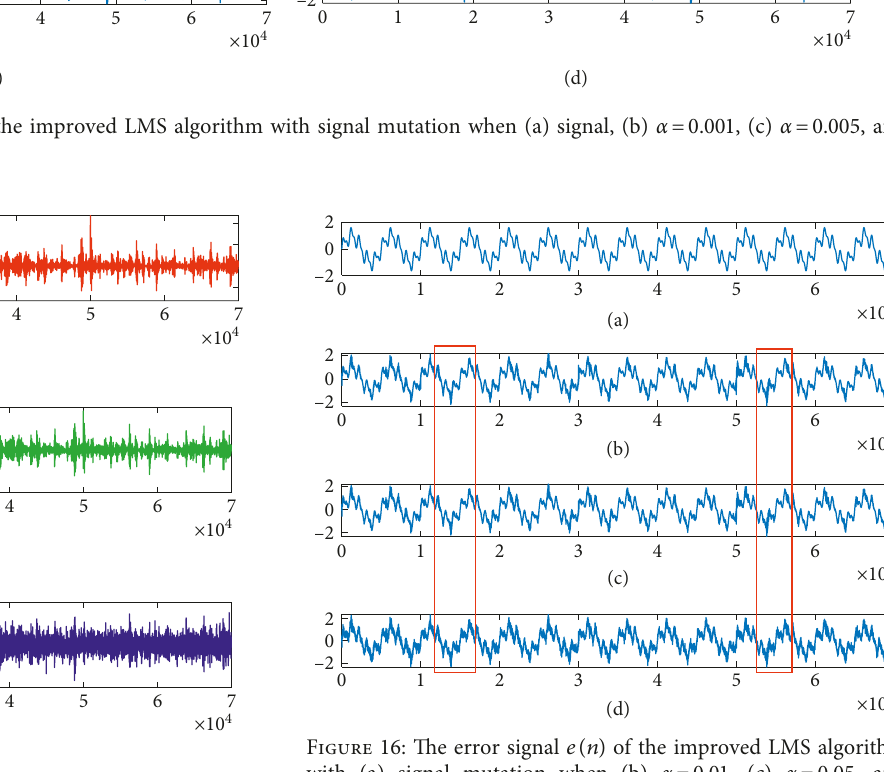
Figure 15: The residual noise of the improved LMS algorithm with signal mutation when (a) α residual noise.